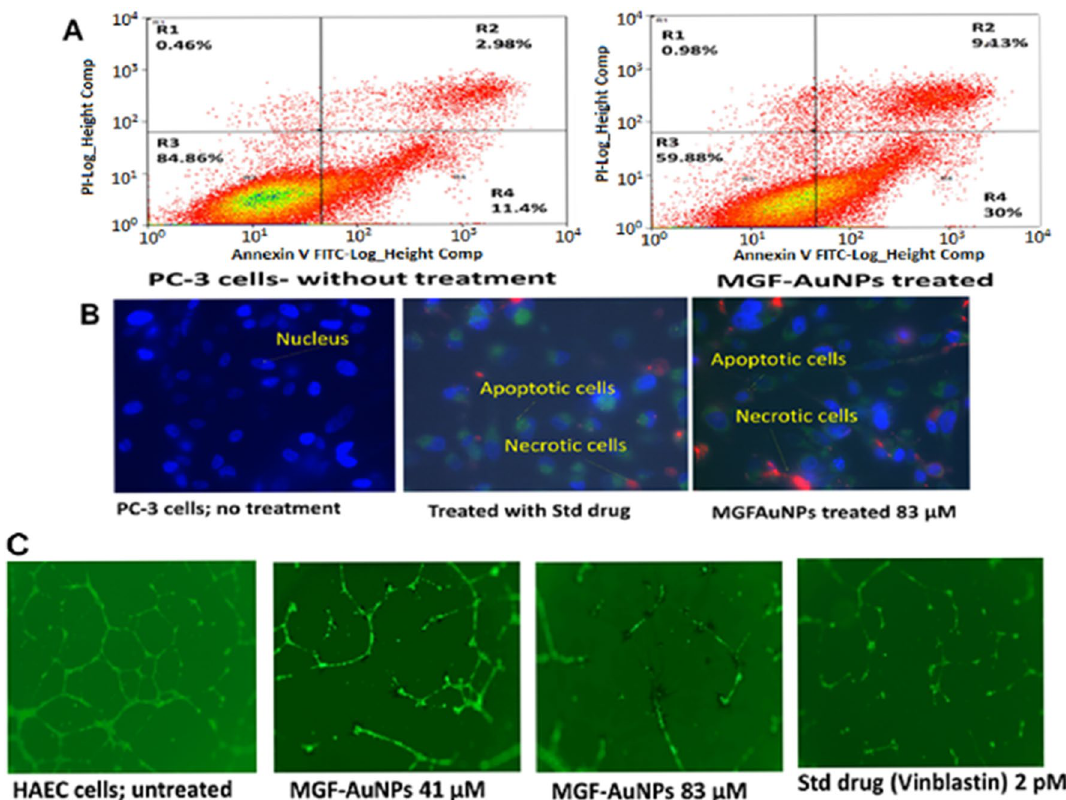
Figure 6. MGF-AuNPs produced apoptosis in PC-3 cells and inhibits endothelial cell tube formation: ( A , B ) PC-3 cells were cultured in 6 well plates for overnight followed by treatment with MGF-AuNPs for 24 h. The cells were harvested and permeabilized. After permeabilization the cells were stained with Annexin V for membrane damage and with Propidium Iodide (PI) for DNA damage. The cells were washed and analyzed by either flow cytometry or fluorescent microscopy; ( C ) 6 well plates were layered with Matrigel and HAECs were cultured on the Matrigel for tube formation. AuNPs at 41 and 83 µM for 24 h were added to the culture. Tube formation was observed under the light microscope and pictures were